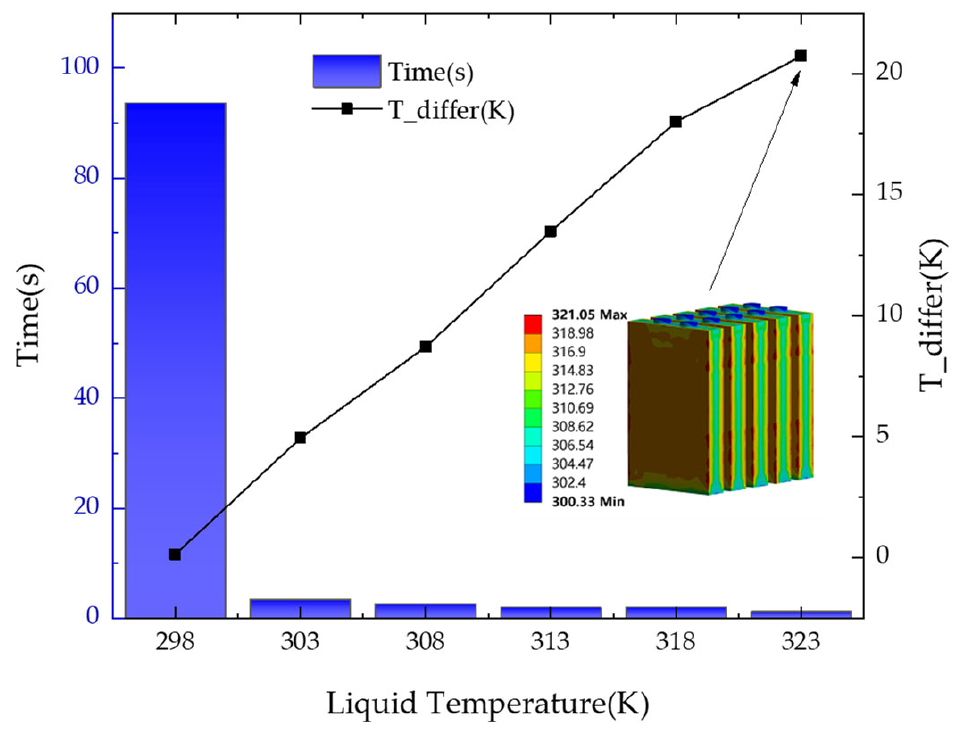
Figure 10. The influence of fluid temperature on BTMS.